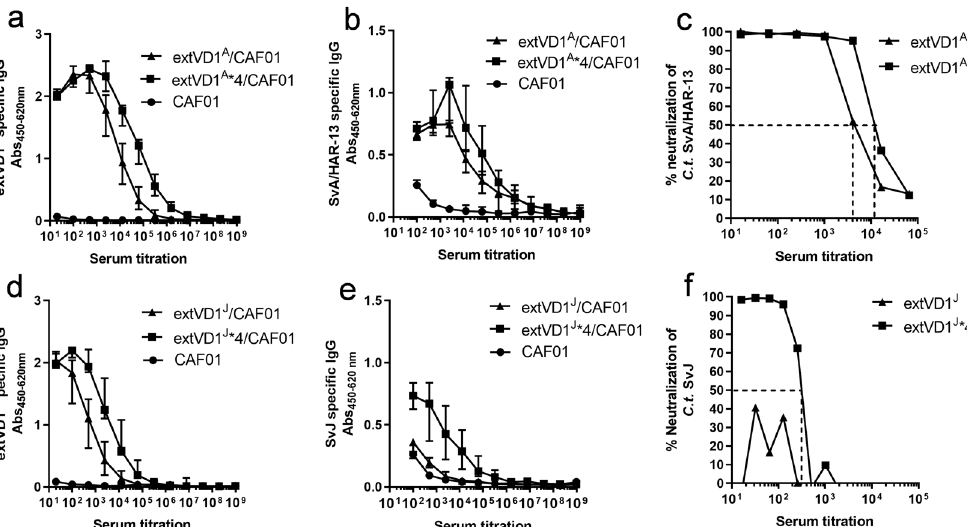
Fig. 1 Immunogenicity of monomers (extVD1) and homologous immuno-repeats (extVD1*4). Plasma samples ( n = 5 – 6) were isolated 1 week post third subcutaneous (s.c.) vaccination of A/J mice with 10 µg of extVD1 A , extVD1 J , extVD1 A *4, or extVD1 J *4 emulsi fi ed in CAF01, serially diluted and added to extVD1 A ( a ), extVD1 J ( d ), intact C.t . SvA/HAR-13 ( b ), or intact C.t . SvJ ( e ) coated plates, and antigen-speci fi c IgG was analyzed by ELISA. Each dot represents the median OD value with 25th and 75th percentiles at each titration step. In vitro neutralization of C.t . SvA/HAR-13 ( c ) and C.t . SvJ ( f ). Sera isolated 3 weeks post third vaccination were pooled for each group ( n = 5 – 6), titrated, mixed with a fi xed concentration of bacteria, inoculated onto a HaK cell monolayer, fi xed, and inclusions counted. The dotted line indicates the reciprocal NT 50 titer. The individual experiments were repeated twice with similar results.